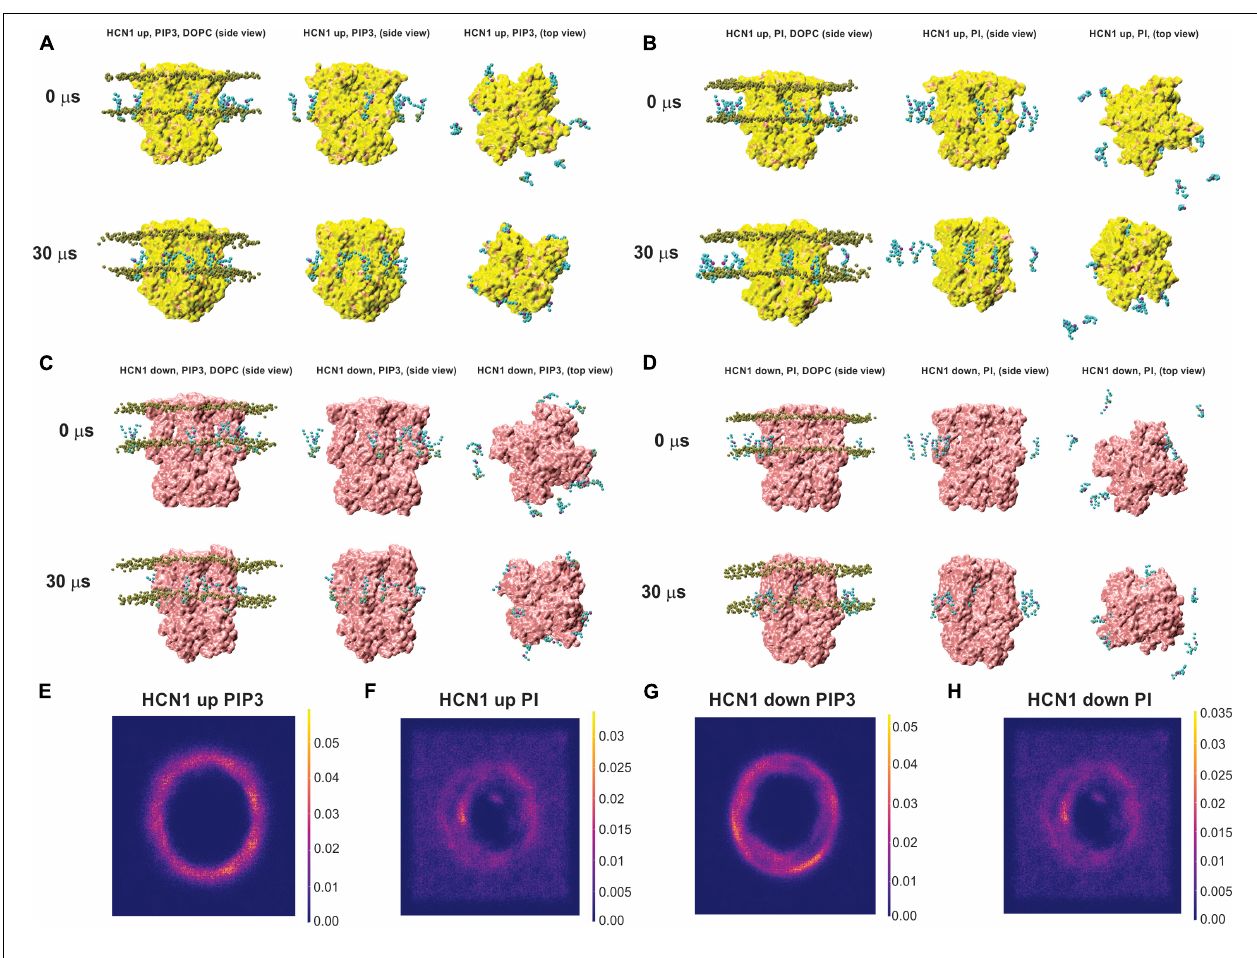
FIGURE 4 | Coarse-grained (CG) simulations of POP3 and PI for HCN1 with activated and deactivated VSDs. Snapshots of HCN1 (yellow) with the VSD in the up (closed) or down (activated) conformations embedded in a DOPC membrane doped with PIP3 (POP3 in the Martini FF) (A,C) or POPI (B,D) at the onset and after 30 µ s of CG simulations. For orientation, phosphate headgroups of DOPC are shown in brown on the left of each panel, but are removed in other panels for